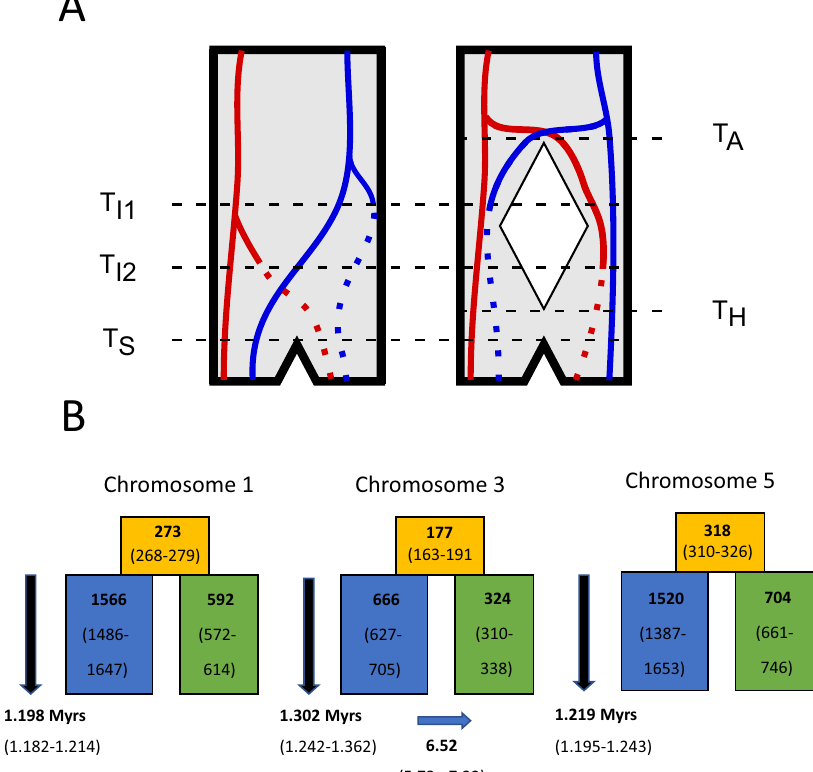
Fig. 1 | Evolutionary history ofinversions.A Alternative population scenariosfor twoinversions(lineschangingfromsolidtodotted)appearingatseparateloci(red and blue) at timepoints T I1 and T I2 , respectively. In the left scenario, the inversions appear as polymorphisms within a single ancestral population and eventually get sorted into one of two subspecies (T S ). The divergence times of the inverted and non-inverted haplotypes will, in this case, re fl ect the timepoints of the inversion events. In the right scenario, an ancestral population splits into two allopatric populations (T A ) and inversions appear in one of them. The two populations later comeintosecondarycontactandmerge(T H ),beforetheinversionsgetsortedinto one of two subspecies (T S ). In this scenario, the divergence times of the inverted